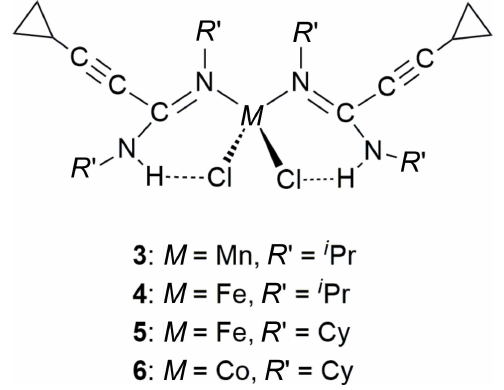
lize isotypically in the orthorhombic space group Fdd 2. The metal atom is situated on a crystallographic twofold axis and is